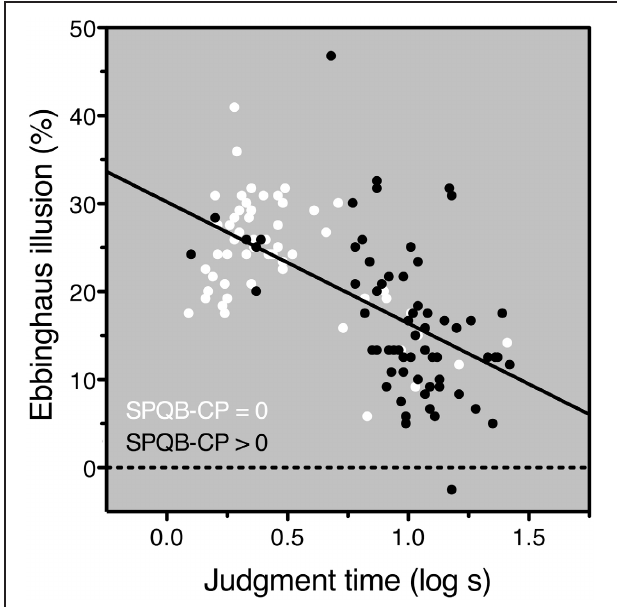
FIGURE 2 | Results. Ebbinghaus-illusion magnitude plotted against log-transformed judgment time. Subjects with an SPQB-CP score of 0 are represented in white; those with an SPQB-CP score larger than 0 are represented in black. The regression line is a fit to all data points regardless of SPQB-CP score (i.e., regardless of symbol color). Note that individuals with a positive SPQB-CP score tend to be less susceptible to the Ebbinghaus illusion, but to have a longer judgment time, and that regardless of SPQB-CP score, individuals with a longer judgment time tend to be less susceptible to the Ebbinghaus